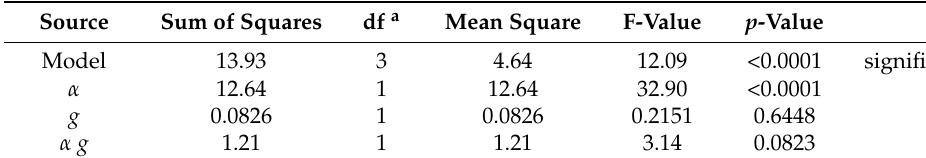
Table 5. ANOVA results. Dependent variable—total cutting energy— E tce (J).